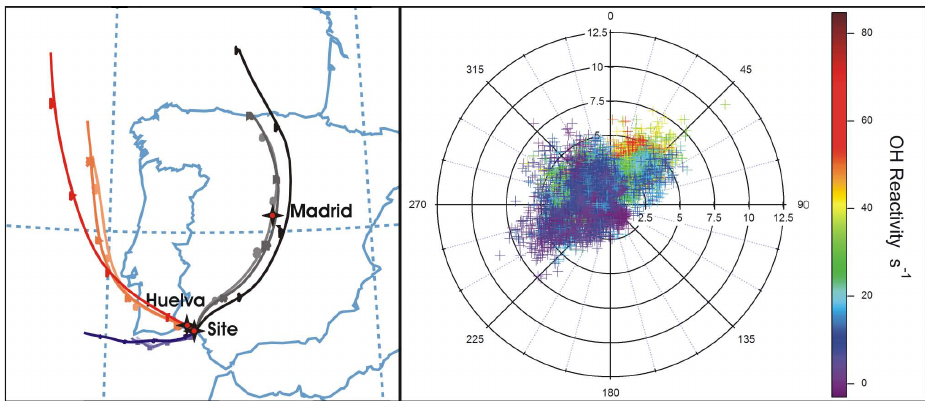
Fig. 1. (a) and (b) Location of the measurement site Base de Arenosillo, 37 ◦ 05 0 58 00 N, 6 ◦ 44 0 17 00 W) as well as Madrid and Huelva (shown with starts) in Spain with select back trajectories at multiple heights from each wind sector (left panel) and wind rose plot showing OH Reactivity measurements (coloured markers and scale), wind speed (radii) and wind direction (angle) for the measurements made during the campaign (right